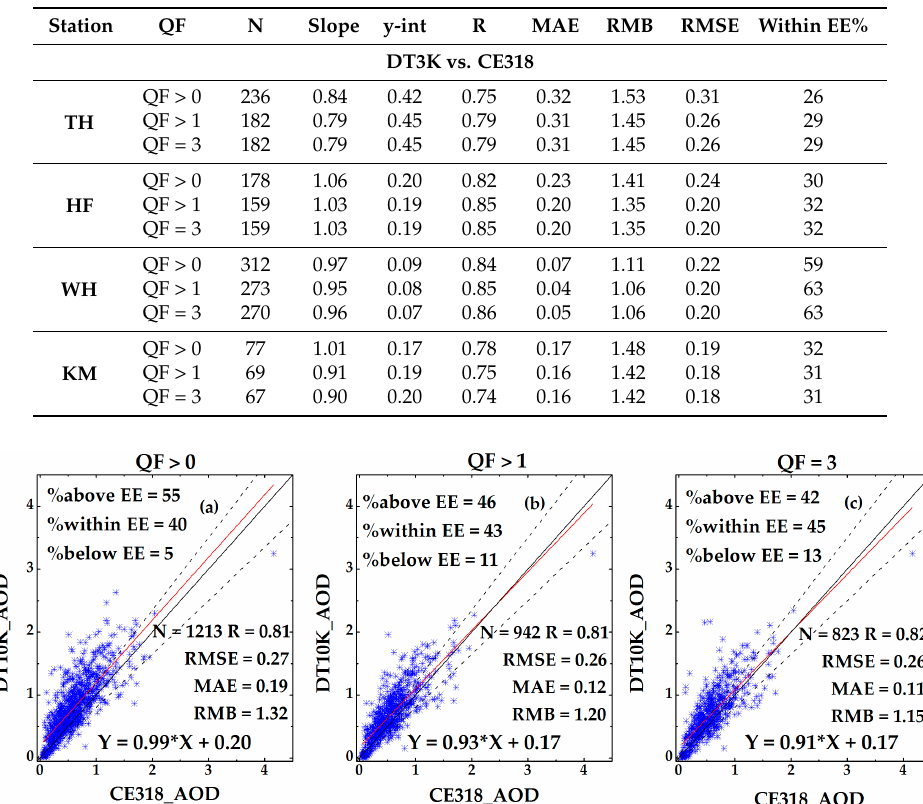
Figure 2. Comparison of DT3K AOD products against CE318 AOD observations over the YRB for the period of 2 May 2012–31 December 2016. The DT3K AOD retrievals are classified by all (QF > 0, ( a )), medium (QF > 1, ( b )) and high (QF = 3, ( c )) quality flags. The black straight line is the 1:1 line; the red straight line is the regression line and the dot lines are the expected error (EE) envelopes. Table 3. Comparison of DT3K AOD products (QF > 0, QF > 1 and QF = 3) against CE318 AOD observations at TH, HF, WH and KM for the period of 2 May 2012–31 December 2016.